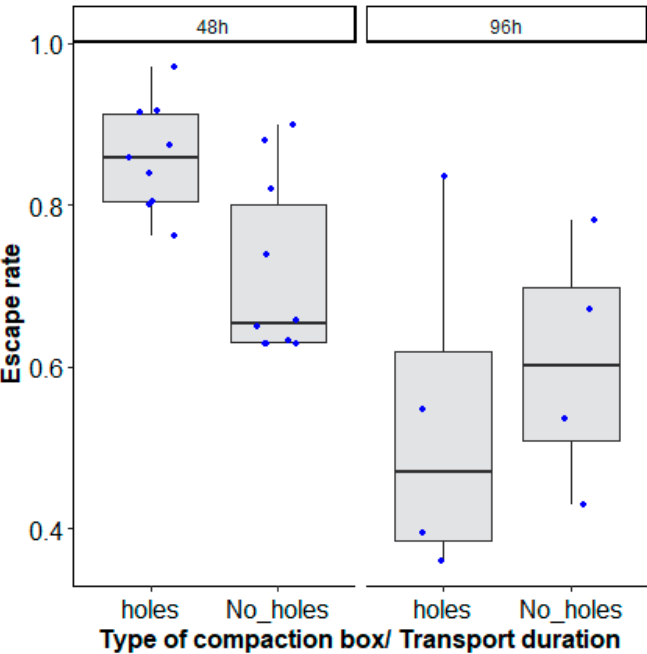
Figure 3. Aedes aegypti , Senegal strain, escape rates according to the type of mosquito compaction box: